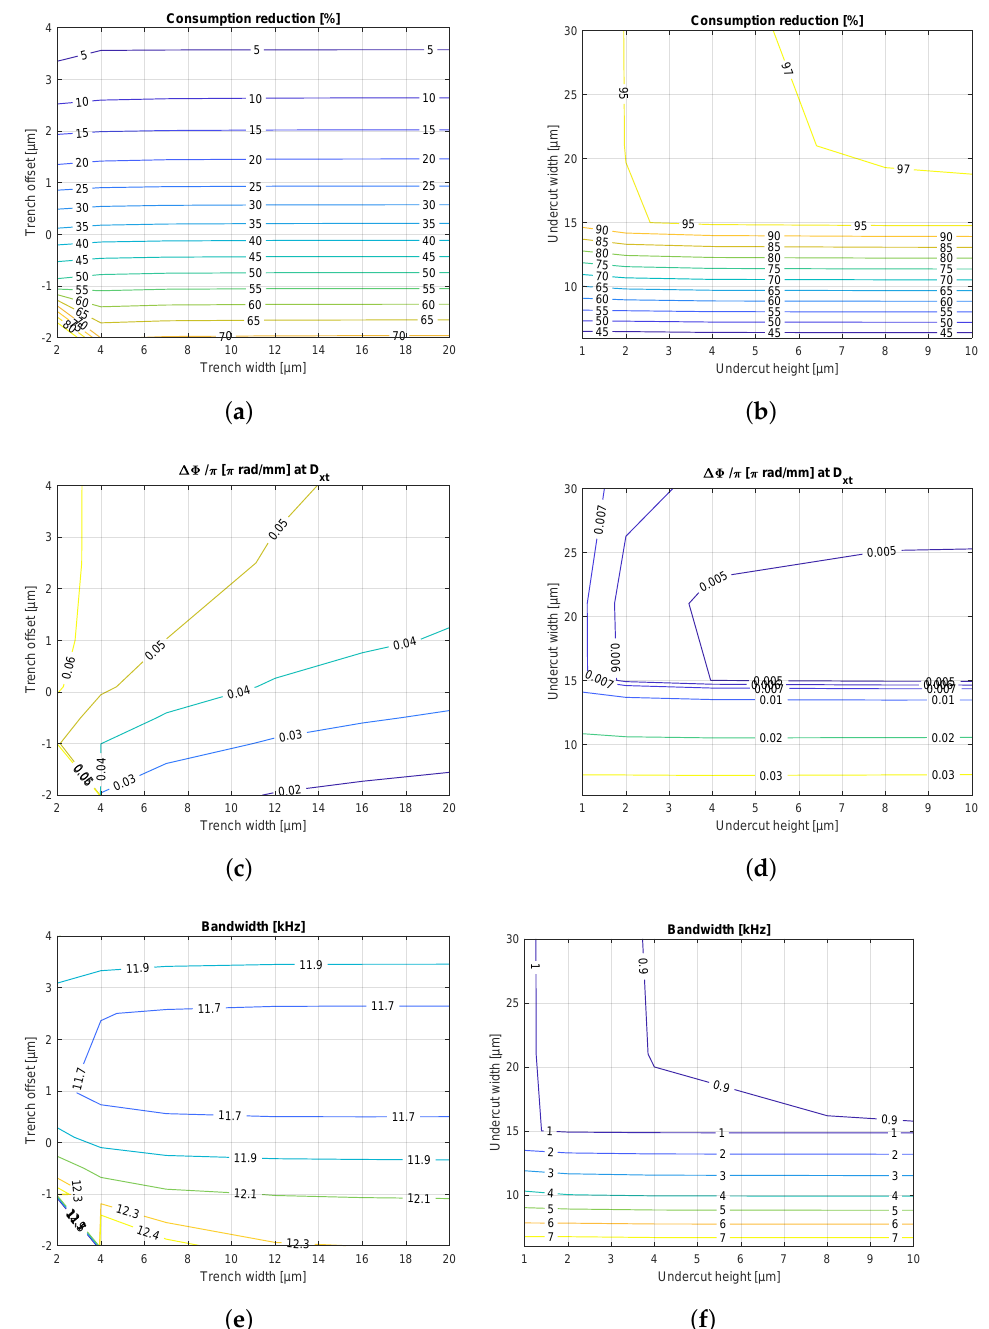
Figure 4. Simulation results for the TO phase shifter with trenches (left column): consumption reduc- tion ( a ), crosstalk phase shift ( c ) and bandwidth ( e ), with l h = 1 mm, w h = 7 µ m, h h = 0.1 µ m. Simula- tion results for the phase shifter with trenches and undercut, right column ( b , d , f ), with h tr = 4.8 µ m, of fset tr = 2.5 µ m, w tr = 7 µ m. Both columns are results for the same heater